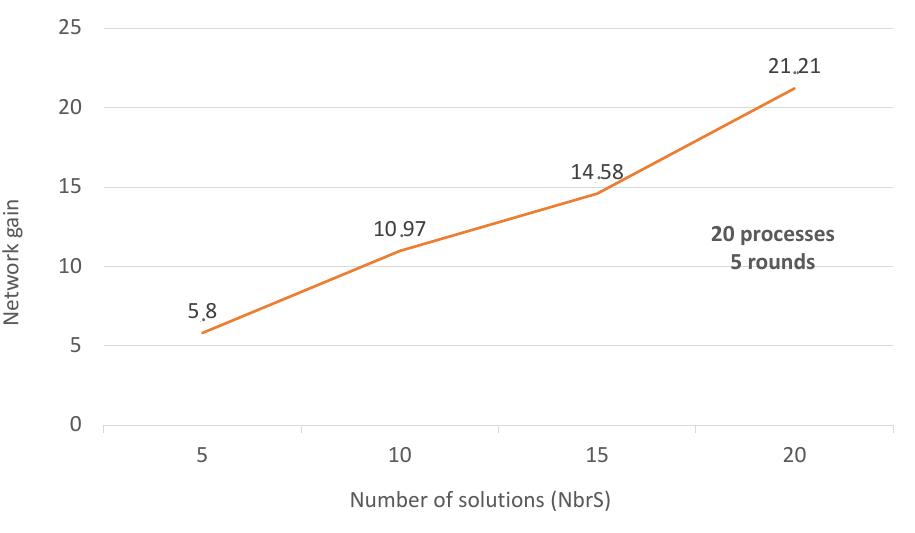
Figure 6. The influence of NbrS. Table 1. The gain rate with leaving competition.